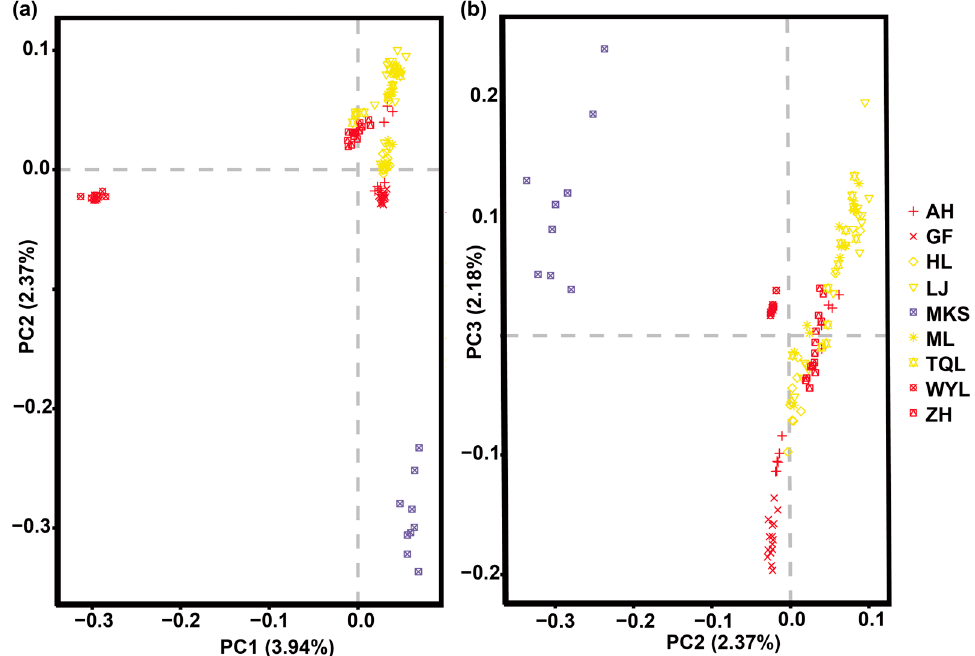
Figure 3. Principal component analysis of 9 populations of P. koraiensis . ( a ) PC1 and pPC2; ( b ) PC2 and PC3. PC: principal component.